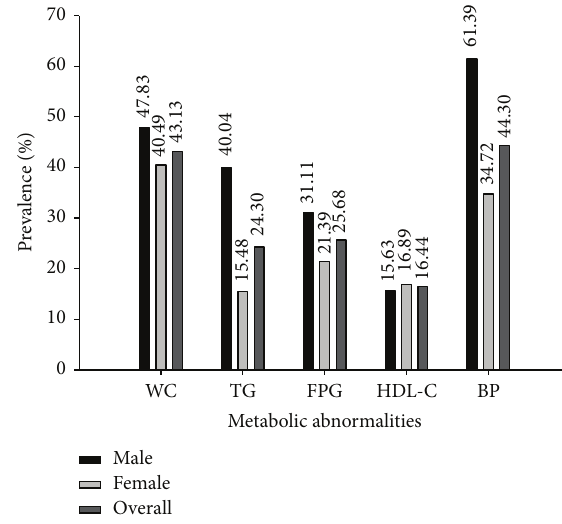
Figure 1: Individual components of metabolic syndrome in the study subjects.